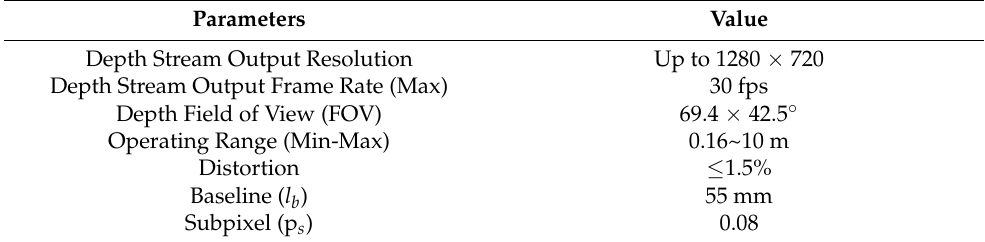
Table 2. The key specifications of Intel RealSense D415.